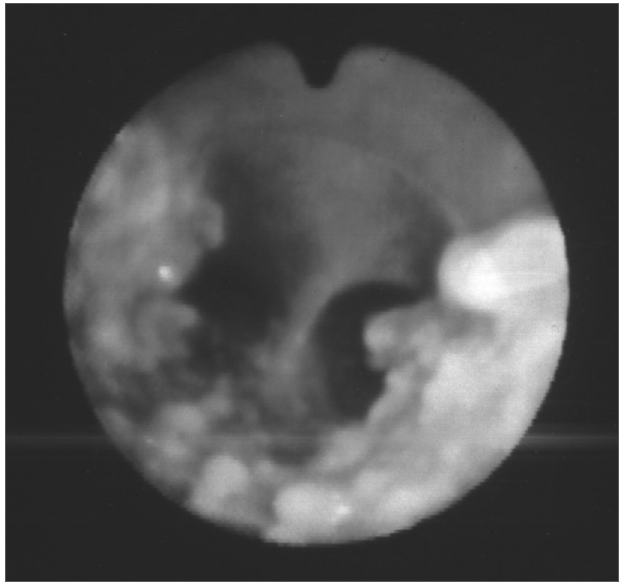
Figura 4. Tomografia computadorizada da traqueia evidenciando lesões nodulares osteocartilaginosas